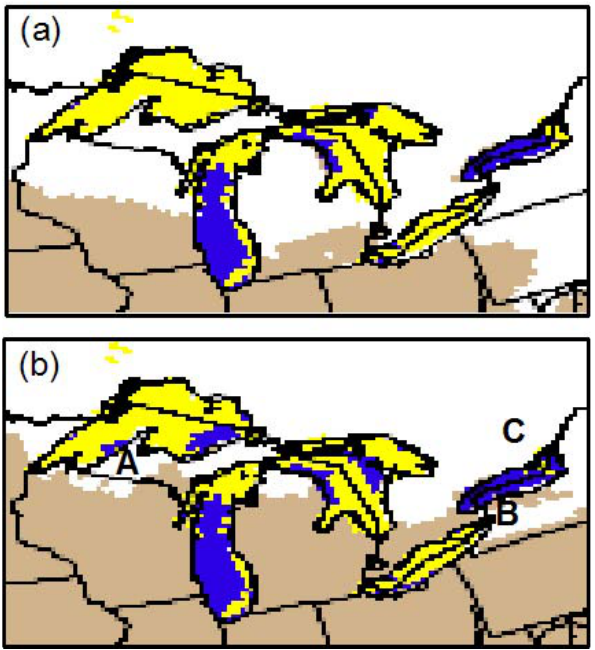
Fig. 16. NESDIS IMS snow cover analysis for the Great Lakes region valid for (a) 16 March, 2003 and (b) 23 March 2003.